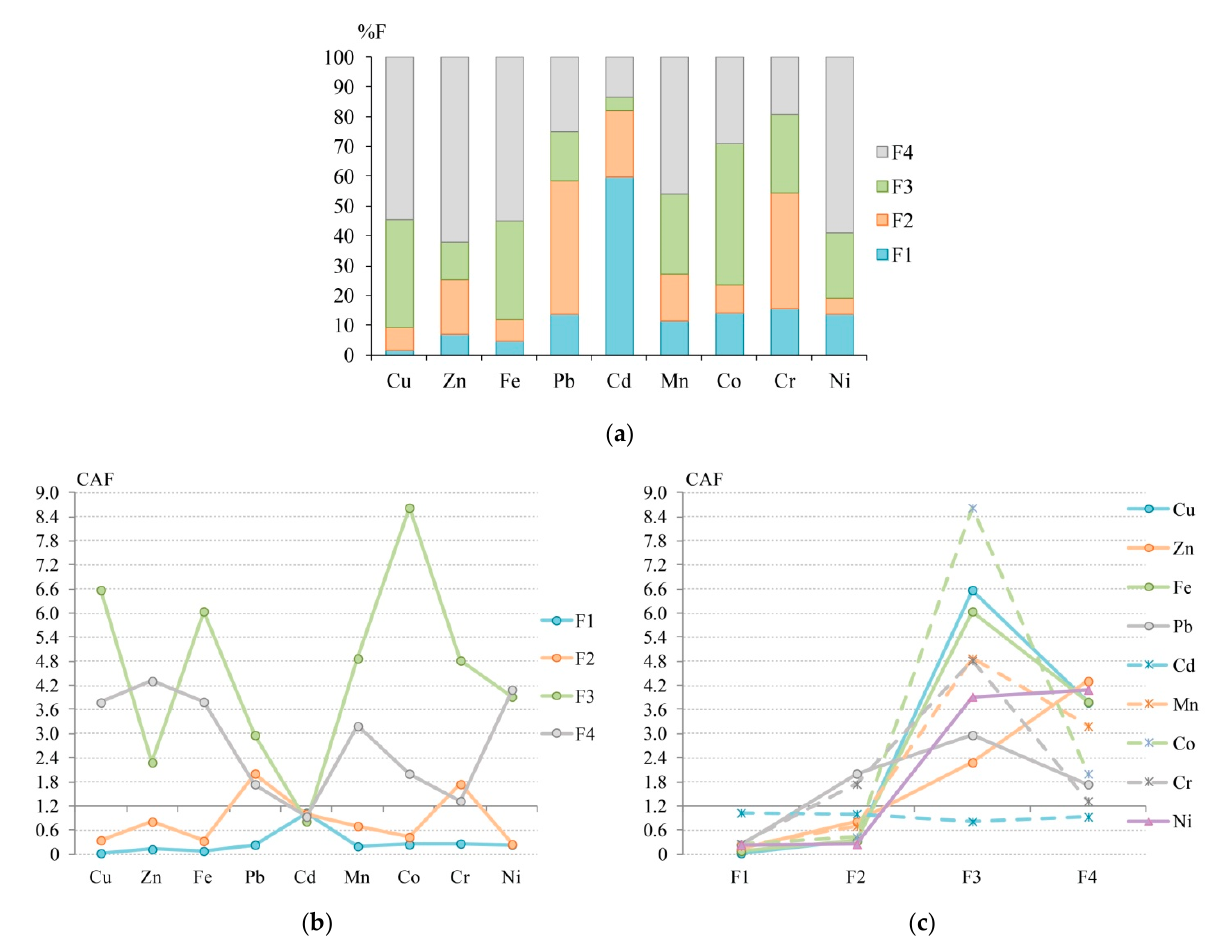
Figure 3. The fractionation distribution of HMs ( a ), levels of chemical affinity factor (CAF) for HMs ( b ), and levels of CAF for chemical fractions ( c ) in atmospheric PM 10 of Pune city—calculated from the data of R. Jan et al. [102]. F1—water-soluble, F2—environmentally mobile (exchangeable), F3—the sum of carbonate and bound to oxides fractions, F4—the sum of organic and residual fractions.